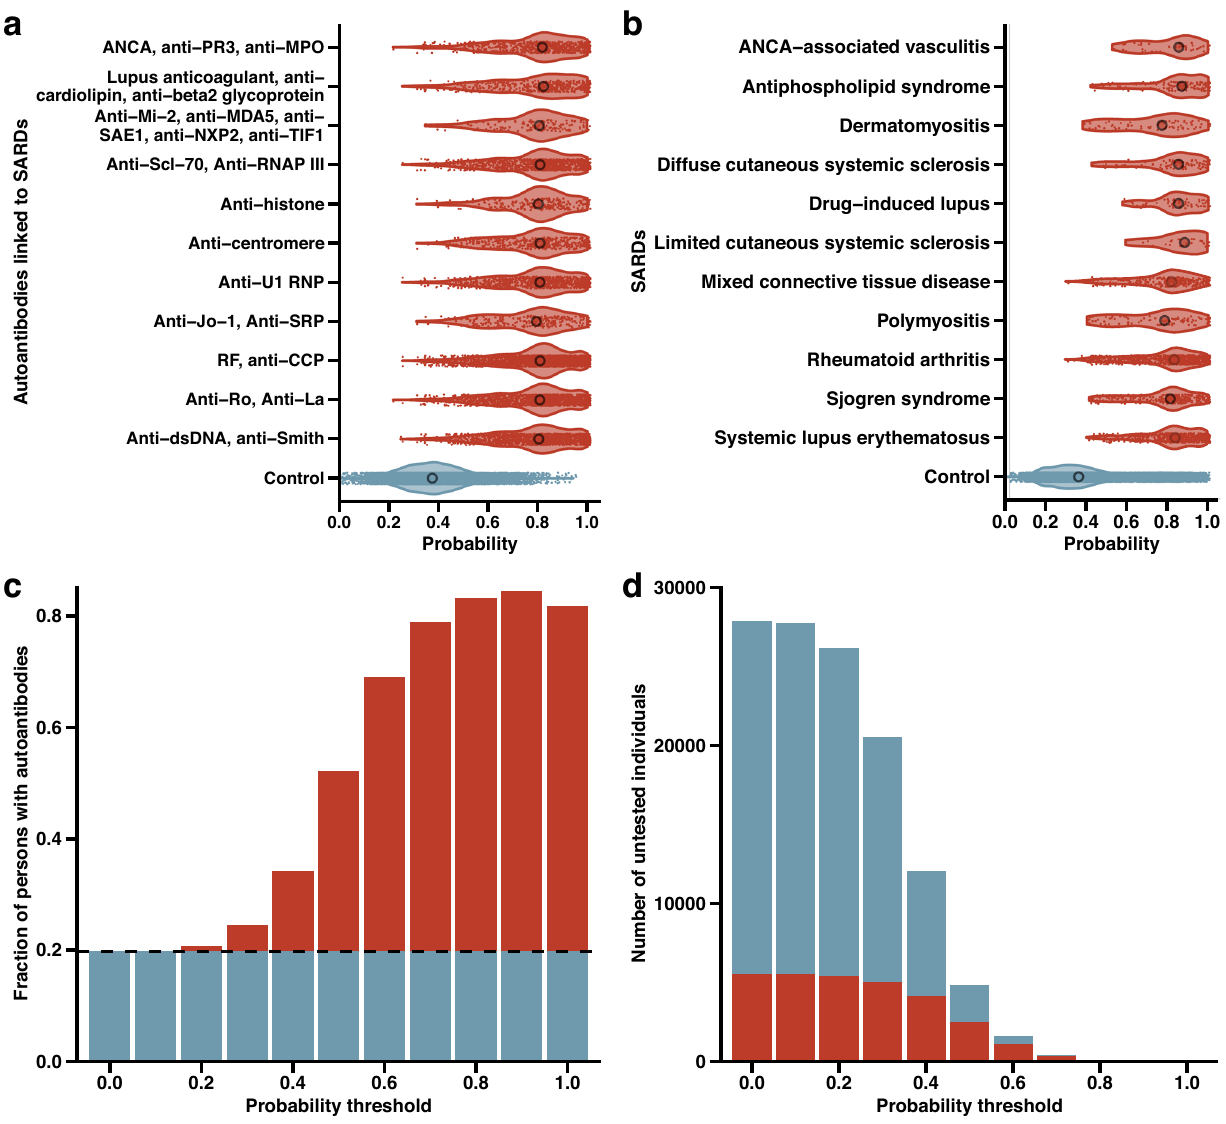
Fig. 2 | Autoantibodies and SARDs identi fi ed in the Bio Me Biobank. a Model- derived probabilities of autoantibody testing for 2748 participants who had auto- antibodies corresponding to SARDs and a rheumatology encounter (red violin plots), and 20,487 controls who were not tested for autoantibodies and did not have a rheumatology encounter (blue violin plot). Median probabilities were compared in autoantibody-tested and untested individuals with Mann – Whitney ’ s U -test. b Probabilities of autoantibody testing for 2026 participants with SARDs diagnoses (red violin plots) and 32,979 controls without a SARDs diagnosis or autoantibody test (blue violin plots). Medianprobabilities were compared in cases and controls with Mann – Whitney ’ s U- test. c Fraction of individuals with